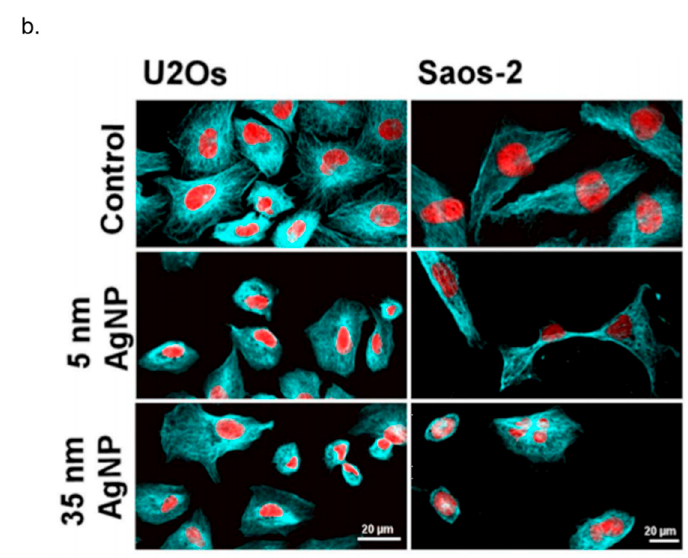
Figure 5. ( a ) AgNPs with PVP coating and Doxorubicin (DOX) loaded polymeric NPs (DOX/PVP/Ag NPs) AND iodine-125 isotope to tracking in vivo the NPs after intravenously injection in normal and solid tumor bearing mice. NPs specifically targeted tumor site for a long period of time making Ag-based NPs as tumor-specific agents for both diagnostic and therapeutic applications. Reprinted from Publication [156] with permission from Elsevier, 2017. ( b ) Confocal images showed the effect of AgNPs on tubulin by apoptotic events induction in U2Os and Saos-2 cells. Adapted from [158] with permission of Springer Nature, 2016.